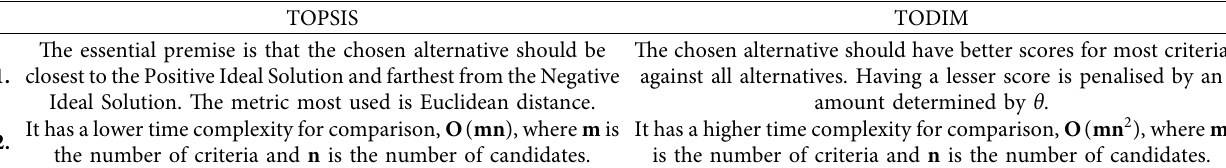
Table 19: Difference between TOPSIS and